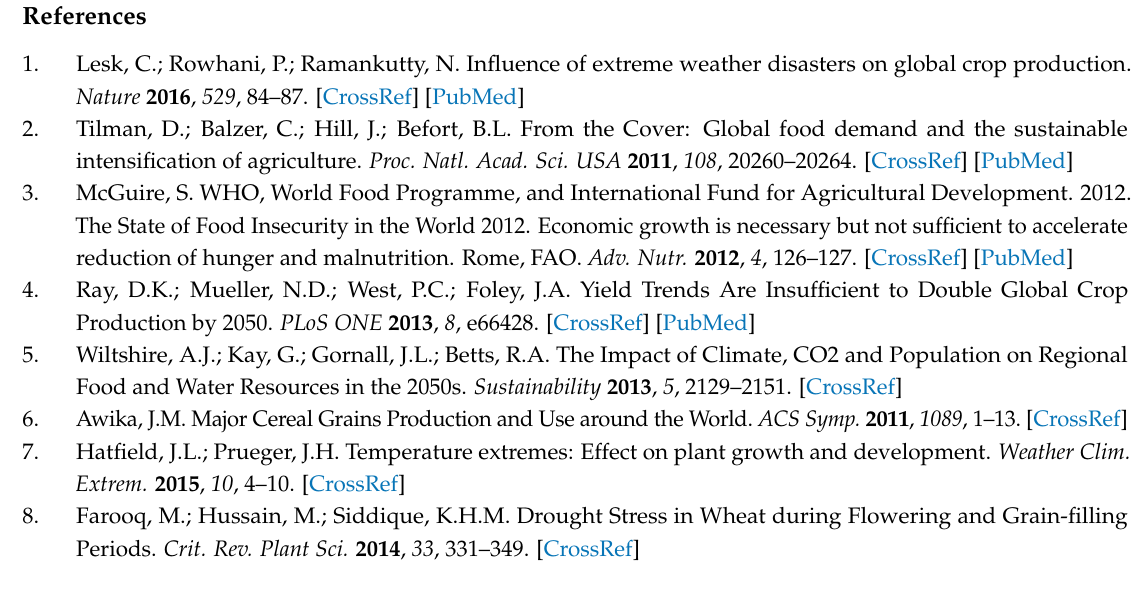
Table S1: The collected information used in the meta-analysis about effects of drought on rice and